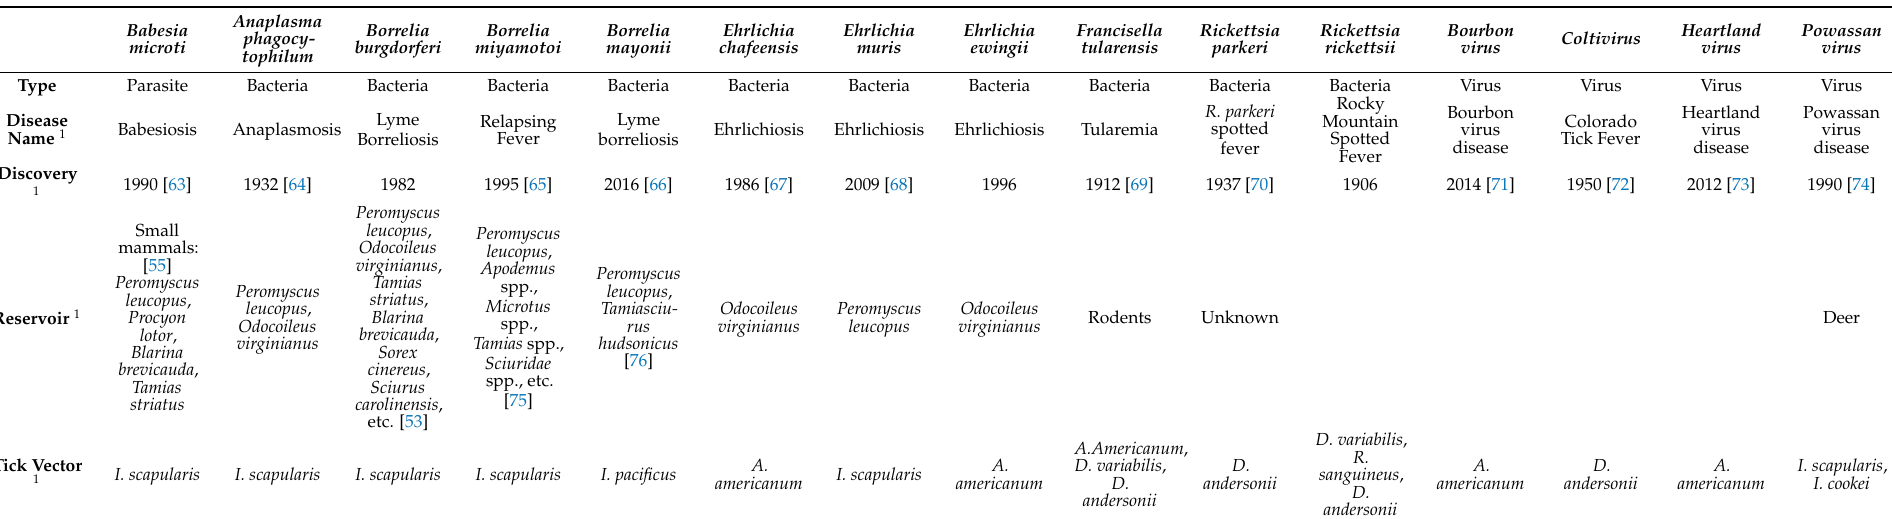
Table 2. Leading tick-borne pathogens within the United States and their